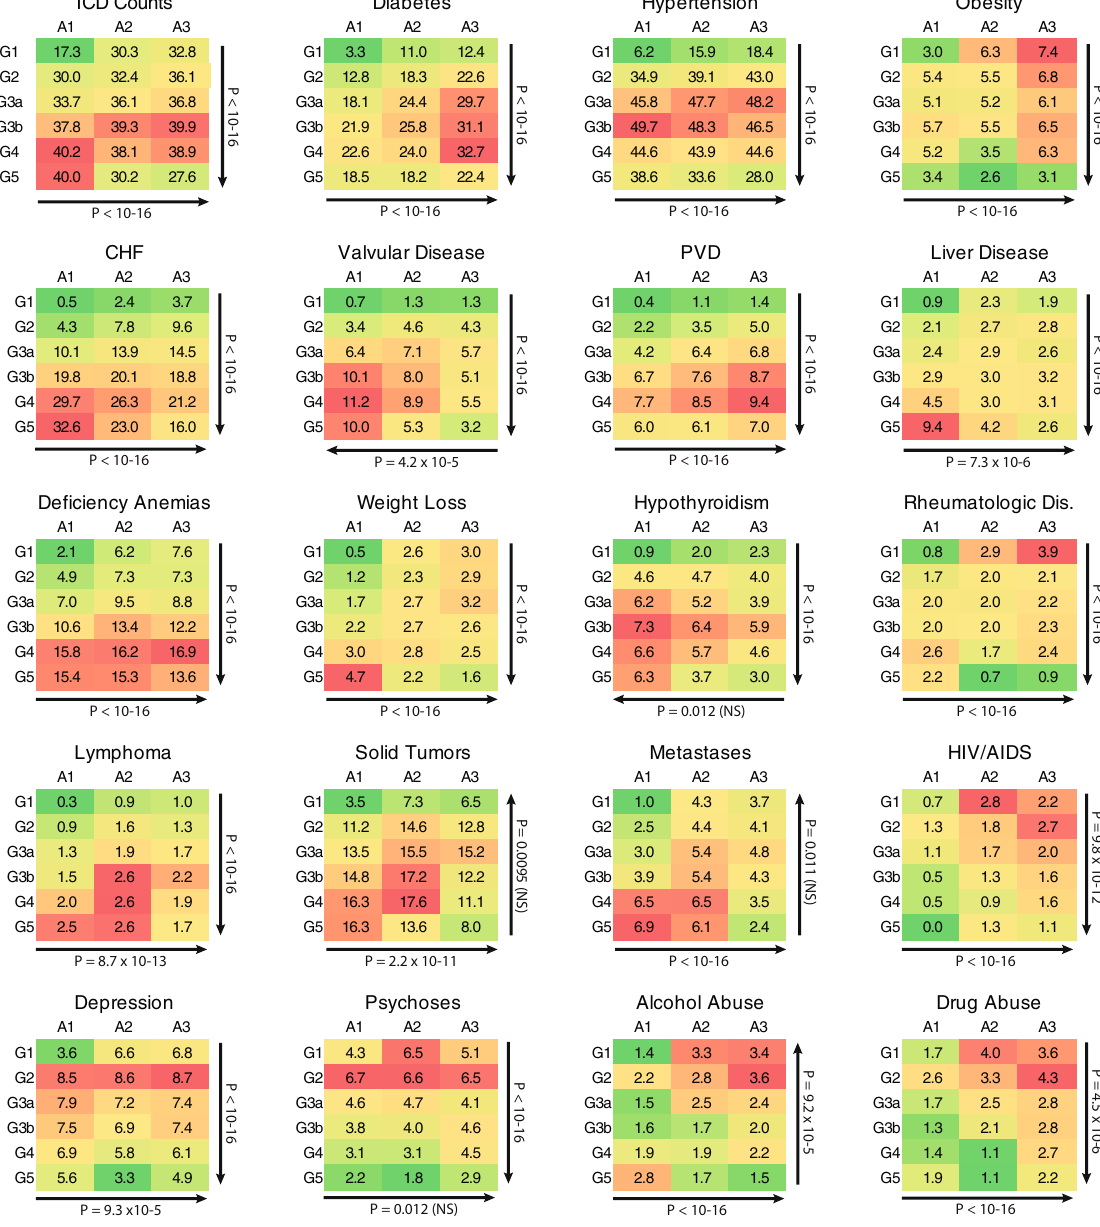
Additional h o2 estimates strati fi ed by stage and race/ethnicity are provided in Table 3, demonstrating that the heritability was consistently higher for African Americans when compared to other ancestral groups and increases with kidney disease severity. The algorithmic A-staging also provided us with an opportunity to estimate h o2 of albuminuria (Fig. 3b). Based on the analysis of 1122 pedigrees, the h o2 of any albuminuria (A2 or A3) was estimated at 0.236 (95% CI: 0.180 – 0.366, P = 0.018). For a subset with heavy albuminuria (A3), the h o2 was 0.490 (95% CI: 0.364 – 0.864, P = 0.015). Because of a smaller number of A-